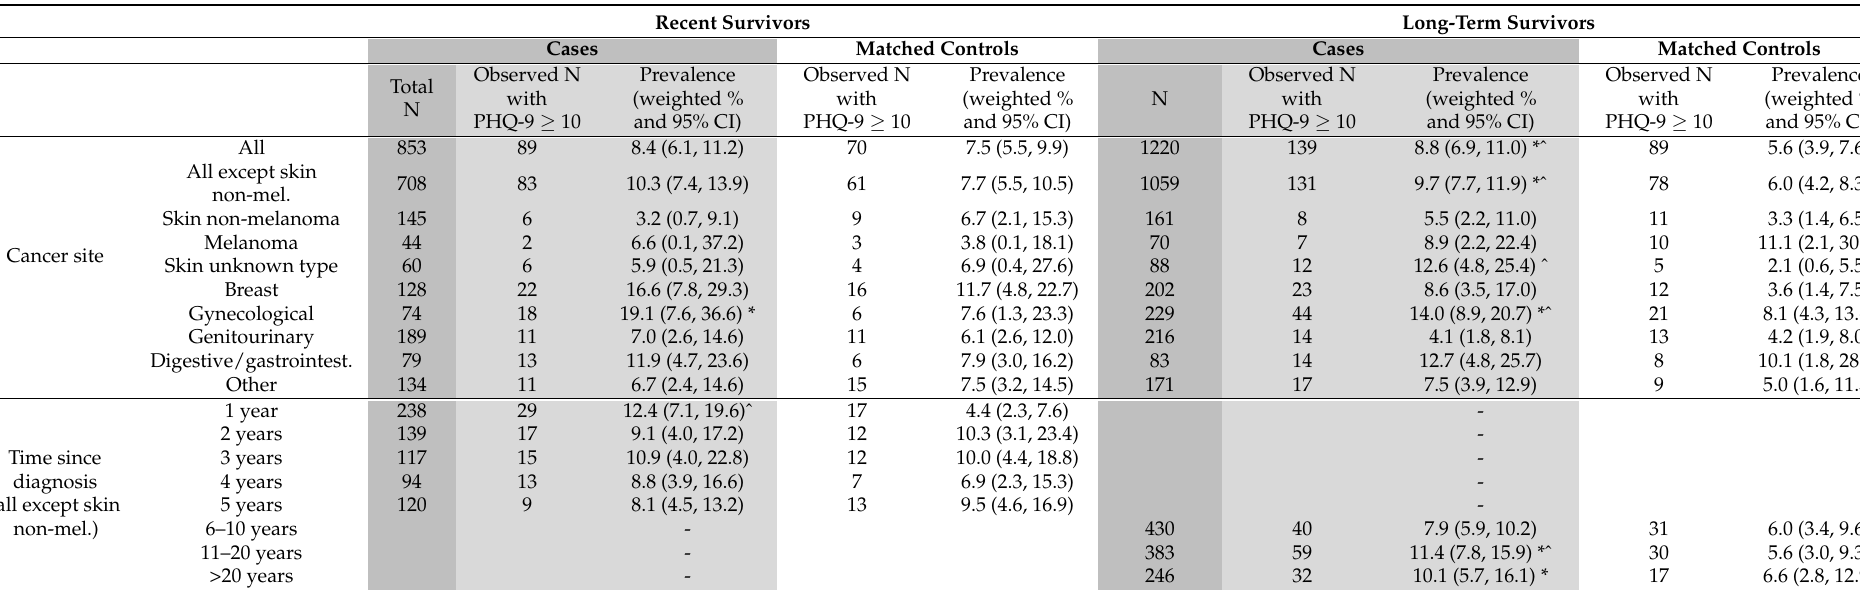
Table 2. Prevalence (percentages and 95% confidence intervals, CIs) of depression (PHQ-9 ≥ 10) according to cancer site and years since diagnosis in each subpopulation of survivors and their controls. Recent Survivors